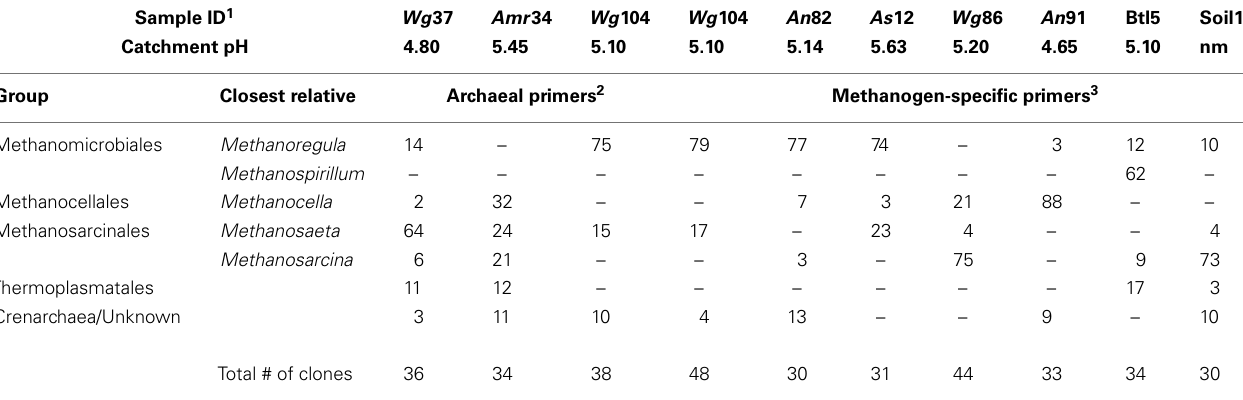
Table 1 | Summary of archaeal ribosomal 16S rRNA clone library results (shown as % of each